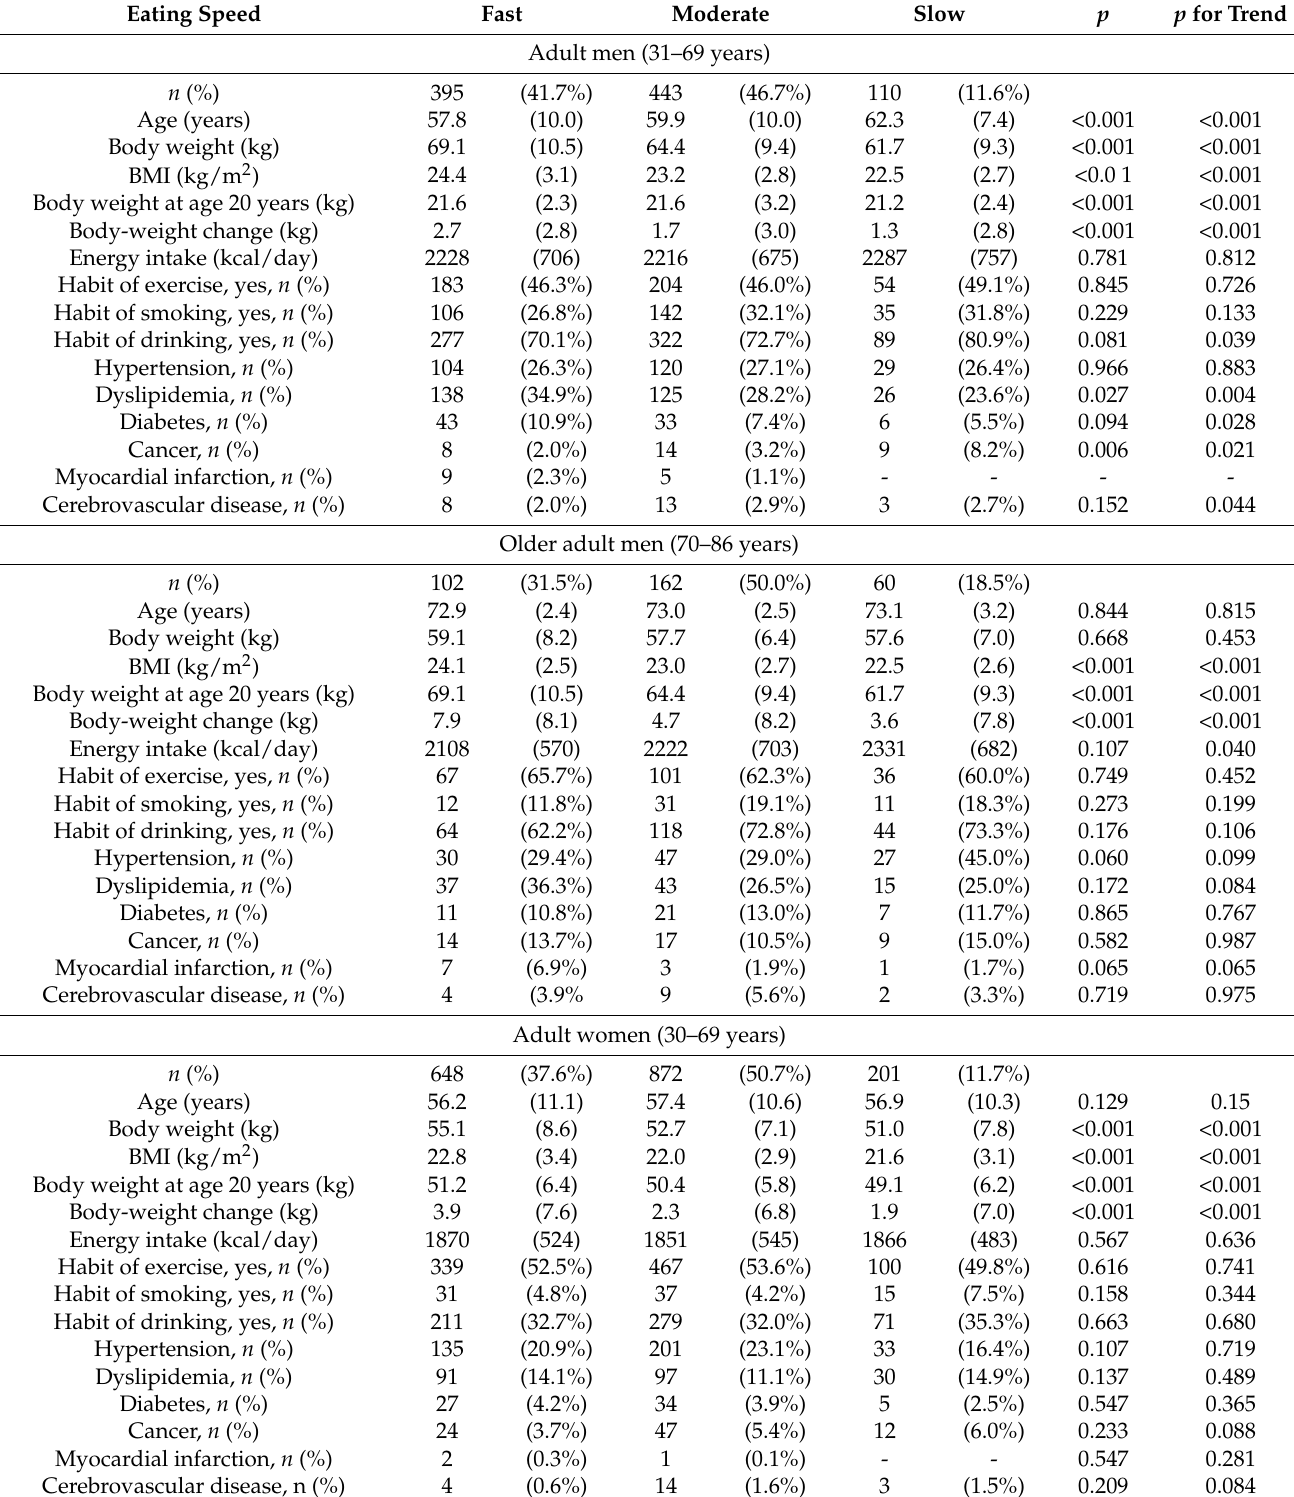
Table 1. Participant characteristics, stratified by gender, age, and eating speed: Takashima, Shiga, Japan,